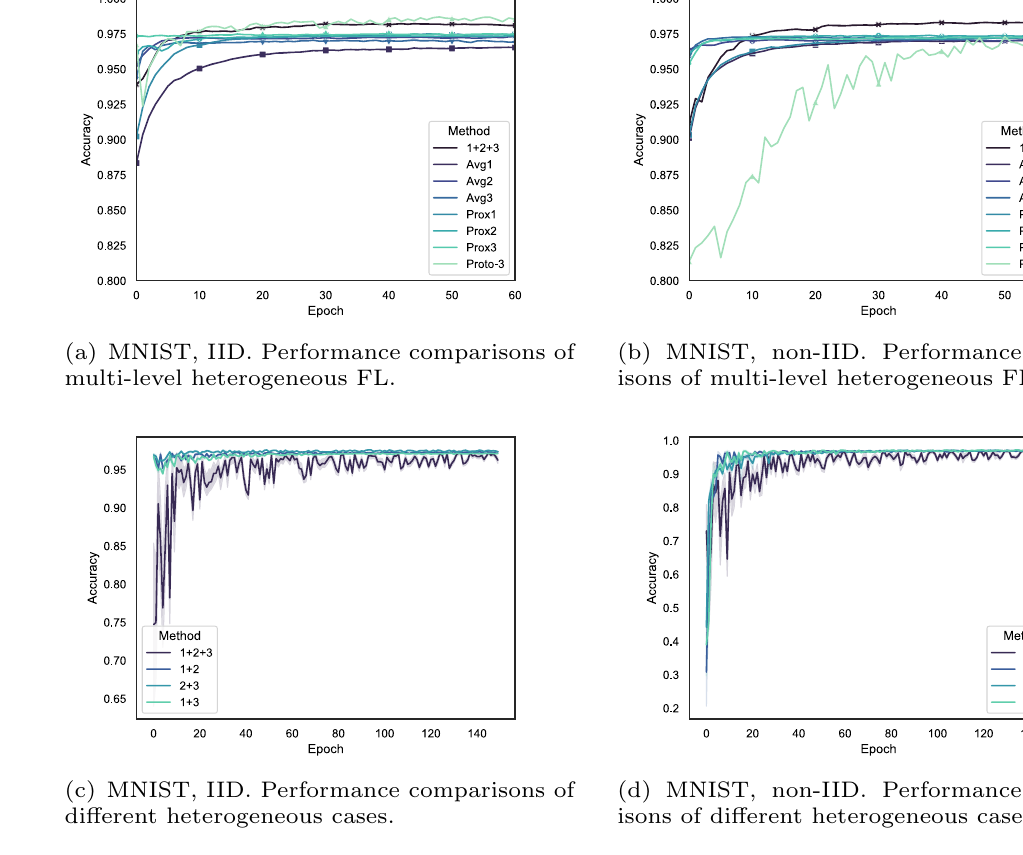
Fig. 6 Performance comparisons of multi-level heterogeneous FL (shown in a and b ) and performance comparisons of different hetero- geneous cases (shown in c and d ) when the dataset is MNIST. “1 + 2 + 3” represents multi-level heterogeneous FL consisting of branch 1,